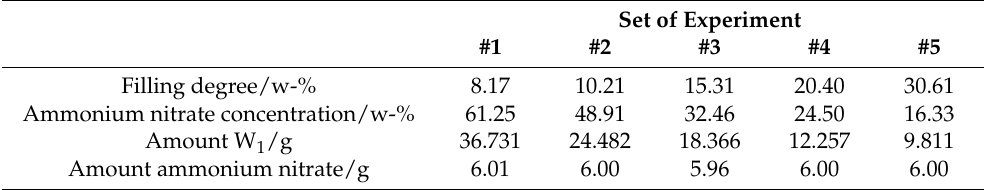
Table 2. Survey of the test series with corresponding weights and